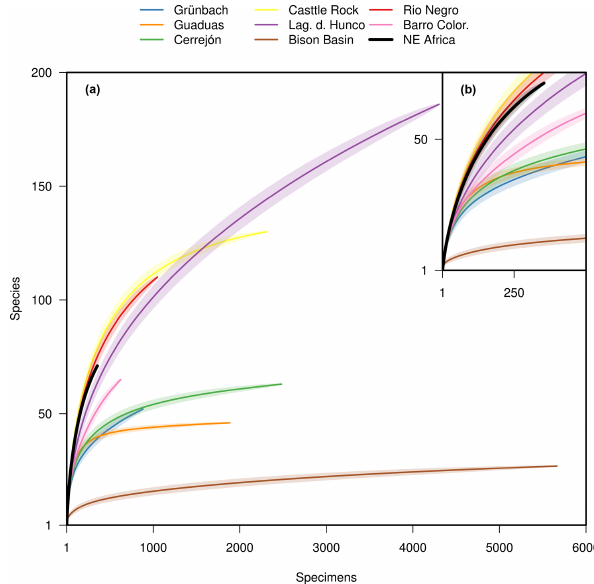
Figure 5. Rarefaction curves. Information on the sites is given in the